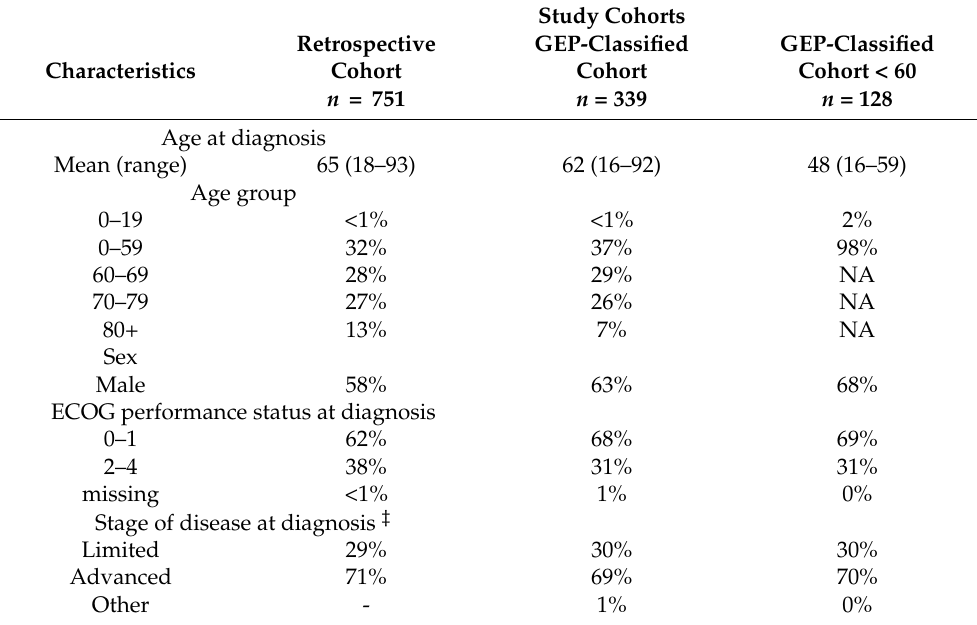
Table 1. Descriptive characteristics for the BC Cancer retrospective cohort and the GEP-classified cohort.